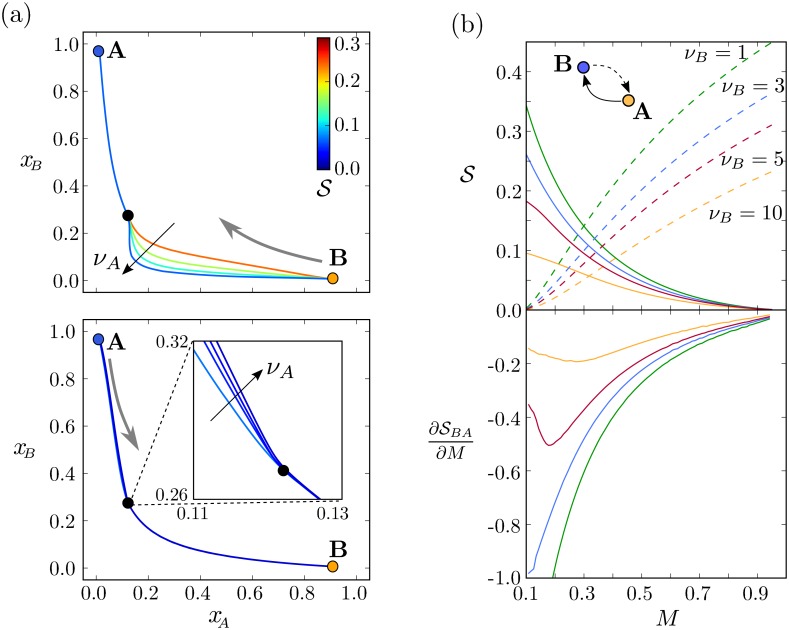
The stochastic switching trajectory and the rate change with the burst size.(a) Changing the relative burst size νA = 1, 3, 5, 10 for both switching processes A → B (top) and B → A (bottom) alters the MAP. The actions for the transitions (coloured lines) decrease and hence switching becomes more rapid as νA increases. The position of the different steady expression states are marked with colour circles for state A (orange) and B (blue) as well as the saddle points (black). Parameters are those of Fig 4. Morphogen signal is M = 0.45. For this value of M the effect on the action is more dramatic for the transition A→B. (b) Burst size modifies the change of action along the tissue. The action along the tissue evaluated for different values of νB (indicated by the different colours) for both switching transitions: B → A (solid line) and A → B (dashed lines) (top panel). The derivative of the action for B → A with respect to morphogen concentration level is shown in the bottom panel. Increasing the morphogen level biases the cells towards state A. The steady state position of the boundary is close to the value of M where dotted and dashed lines cross. The burst size has very little effect on these positions (value of M), but does affect how quickly they are approached. Parameters are those of Fig 4.